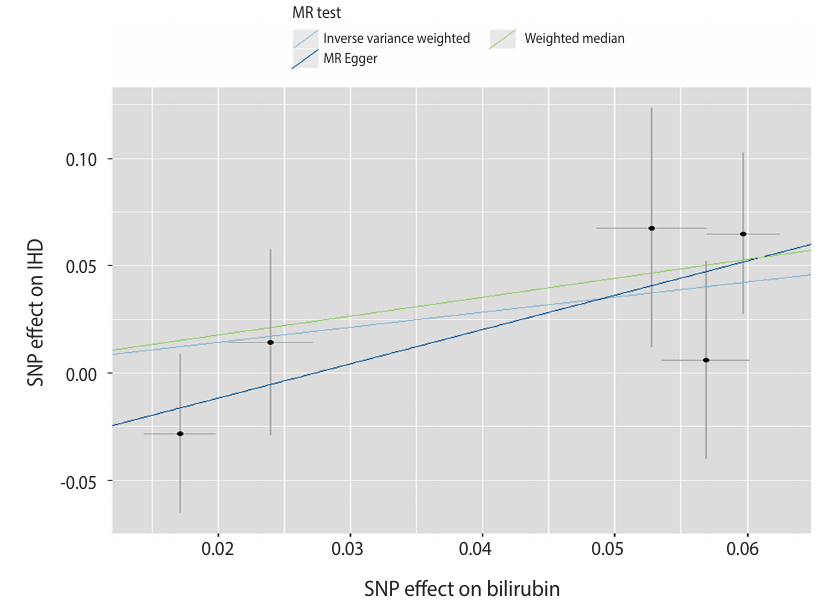
Figure 2. MR analysis regarding the effect of serum bilirubin levels on IHD risk using the genetic instruments. Scatter plot and causal effect of serum bilirubin on IHD risk. The X-axis presents the effect of the genetic instrument of serum bilirubin concentration (in mg/dL); the Y-axis presents the causal effect of the genetic instrument on IHD risk. MR, Mendelian randomization; IHD, ischemic heart disease; SNP, single-nucleotide